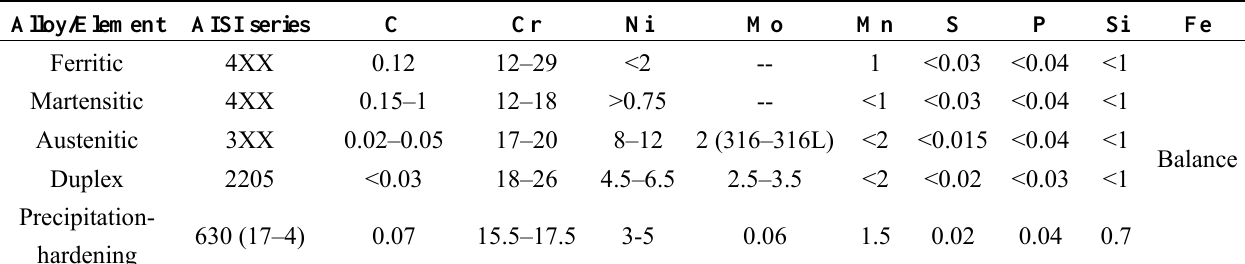
Table 2. Chemical composition and AISI grades of stainless steel alloys (wt.%)